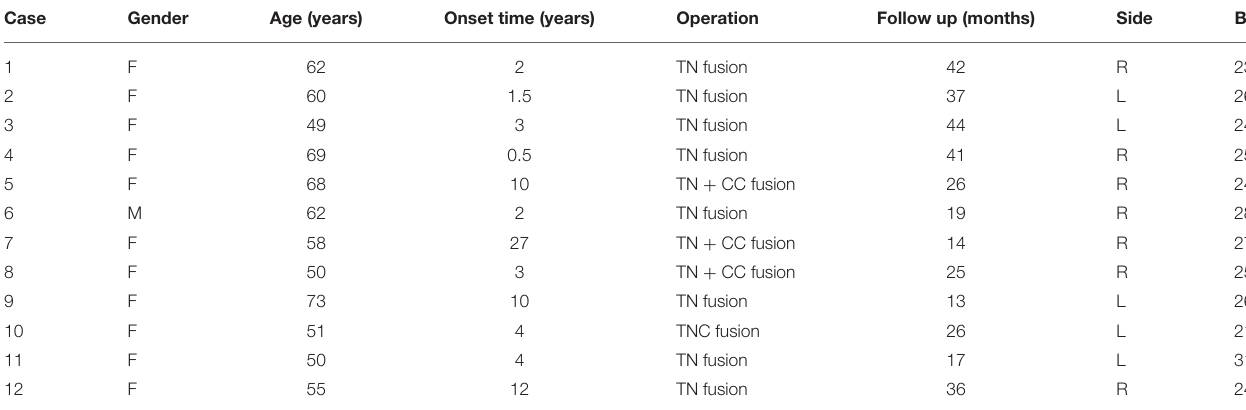
TABLE 1 | General clinical characteristics of the patients.